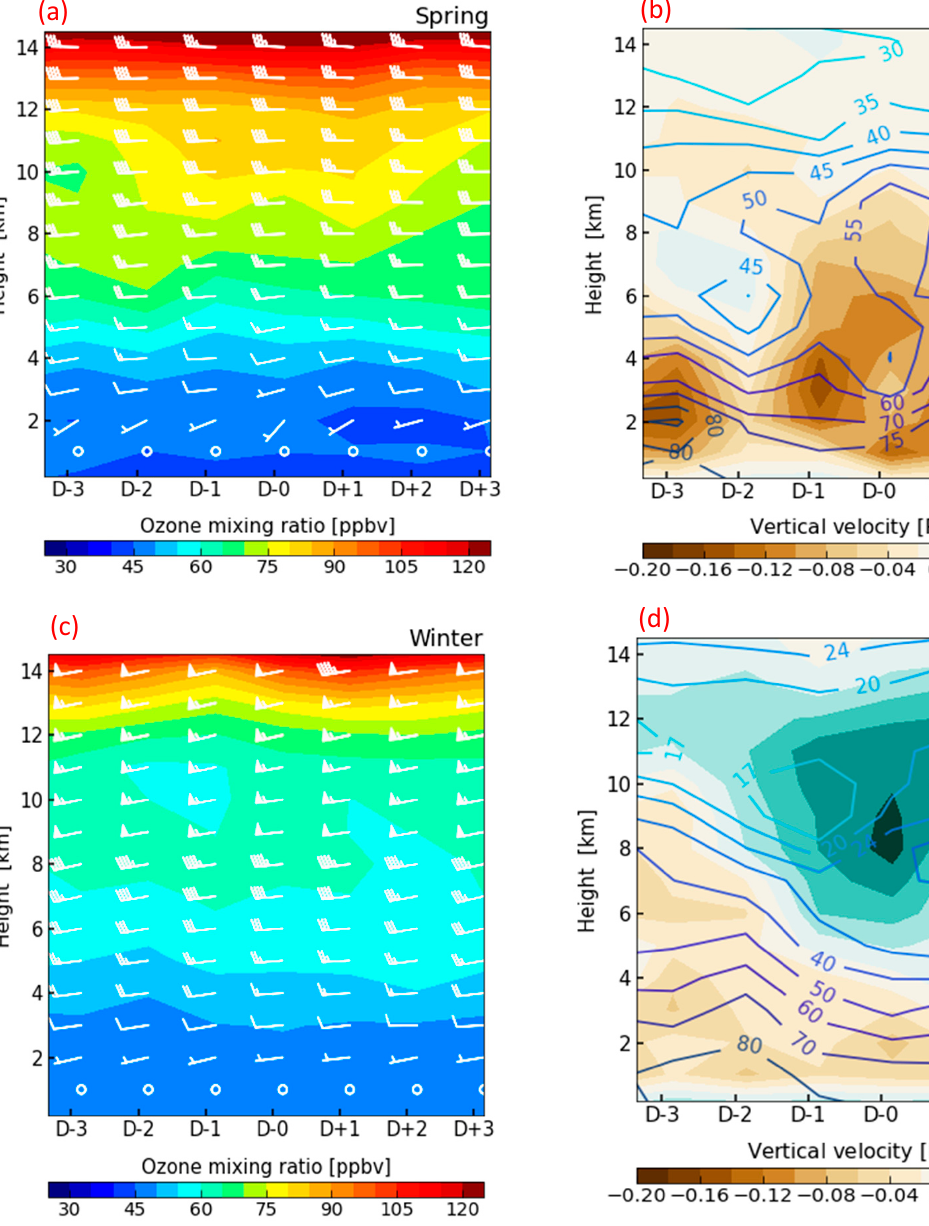
Figure 11. The evolution of ( a ) daily OVMR (shading) and horizontal winds (vectors), and ( b ) vertical velocity (shading) and relative humidity (contours) at different heights during the three days before and after the day of sounding observation in spring, based on ERA5 reanalysis. ( c , d ) shows the same as ( a , b ) but for the winter.